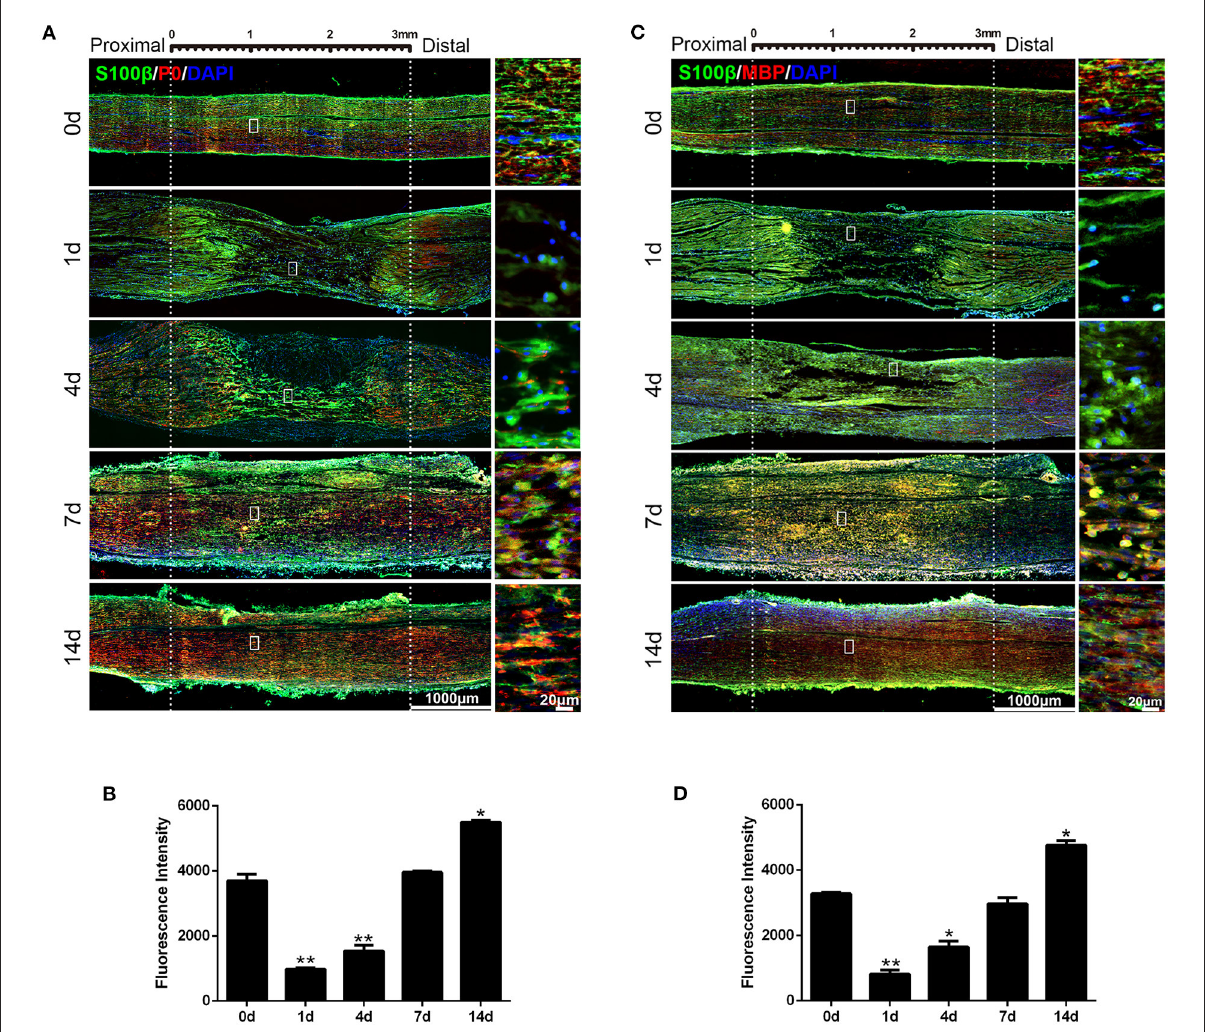
FIGURE5 Expression of P0 and MBP in rat sciatic nerve stumps after peripheral nerve injury. (A) Immunostaining of P0 protein (in red) and S100 β (in green) at 0, 1, 4, 7, and 14 days after sciatic nerve crush injury. DAPI (in blue) was used to label nuclei. Scale bars indicated 1,000 µ m (main image), 20 µ m (magnification). (B) Quantification of the fluorescence intensity of P0 in rat sciatic nerves at 0, 1, 4, 7, and 14 days after nerve injury. * P < 0.05, vs. 0 day, ** P < 0.01, vs. 0 day. (C) Immunostaining of MBP protein (in red) and S100 β (in green) at 0, 1, 4, 7, and 14 days after sciatic nerve crush injury. DAPI (in blue) was used to label nuclei. Scale bars indicated 1,000 µ m (main image), 20 µ m (magnification). (D) Quantification of the fluorescence intensity of MBP in rat sciatic nerves at 0, 1, 4, 7, and 14 days after nerve injury. * P < 0.05, vs. 0 day, ** P < 0.01, vs. 0